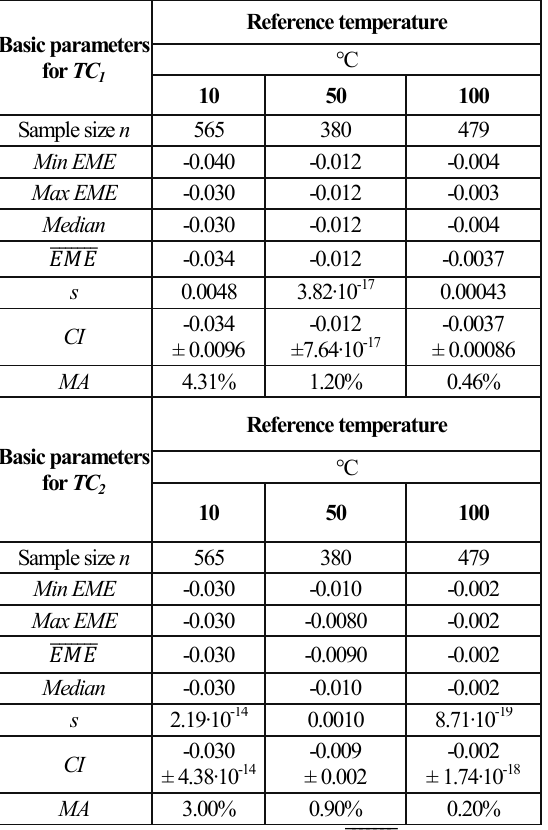
Table 2. The selected method accuracy and basic statistical parameters of the experimental